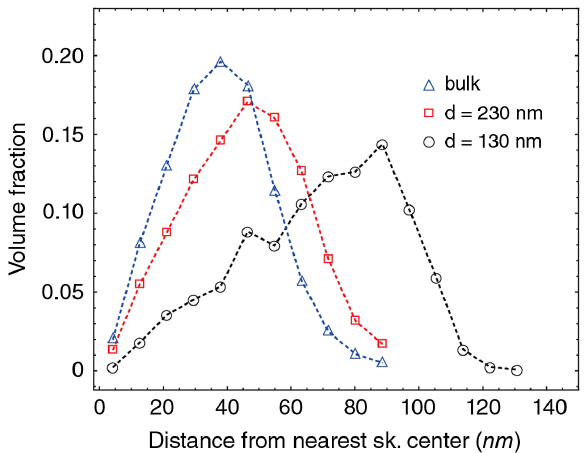
FIG. 12. Diameter of DTCs in bulk and confined BPIII. Volume fraction of all voxels in the simulated chiral structures as a function of the distance from the nearest skyrmion center for thin, thick, and bulk BPIII. The peak corresponds to an effective radius of the skyrmion